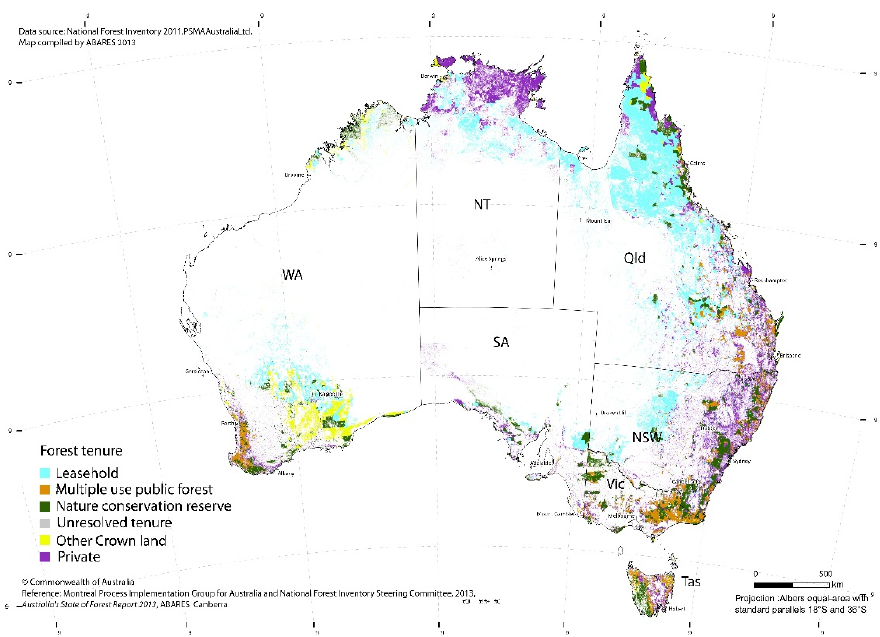
Figure 1. Australia’s forest extent by tenure. Source [1].